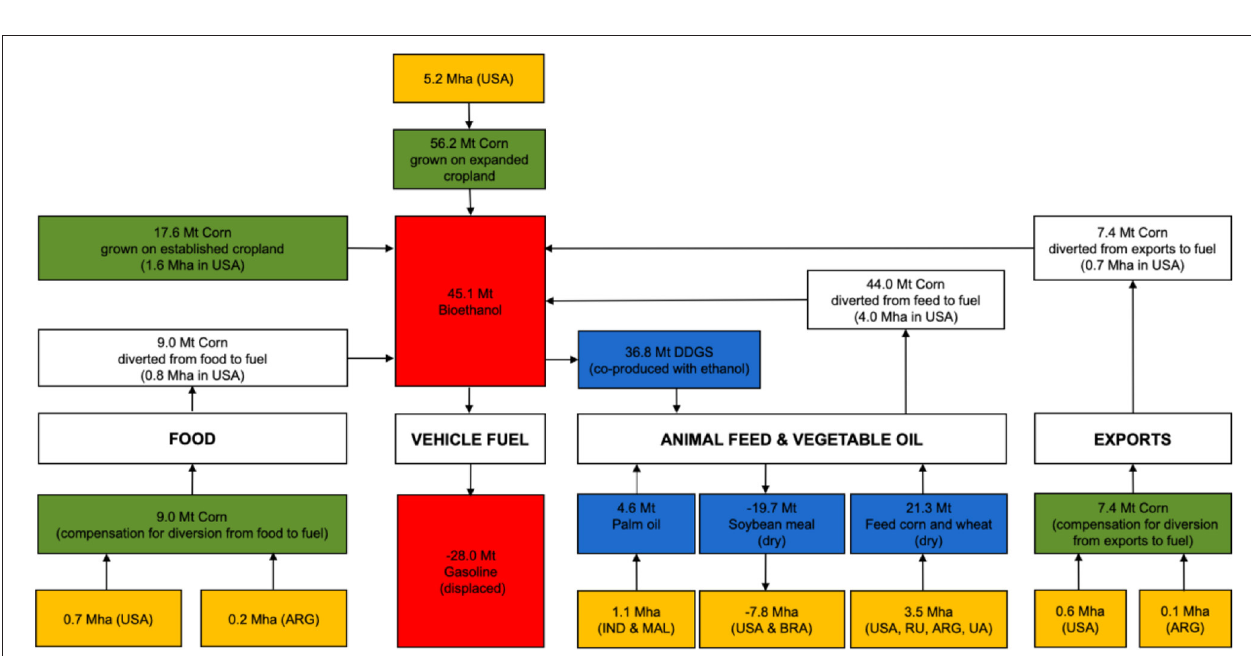
FIGURE 3 | Implications associated with the policy shock of 15 billion gallons of ethanol from corn in the USA, including the balancing of vehicle fuel, food, feed, and vegetable oil markets.